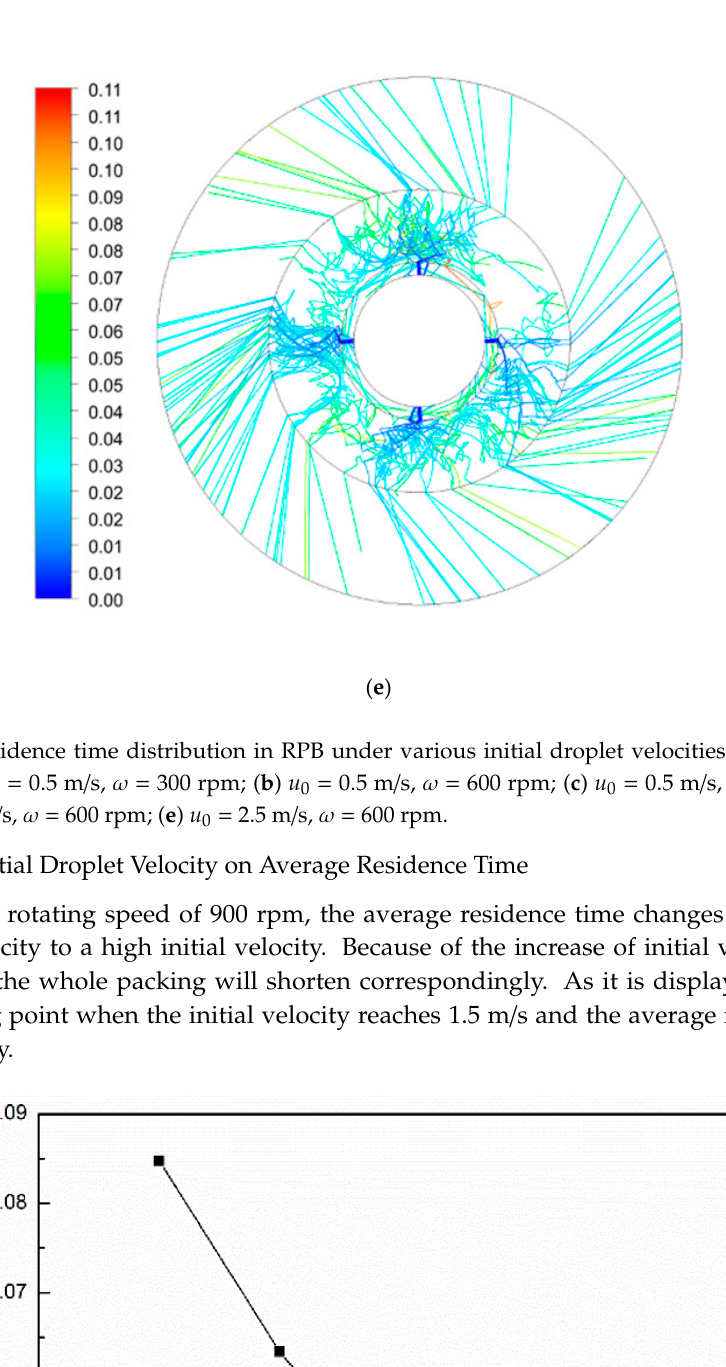
Table 3. Average residence time under various initial droplet velocities and rotating speeds.